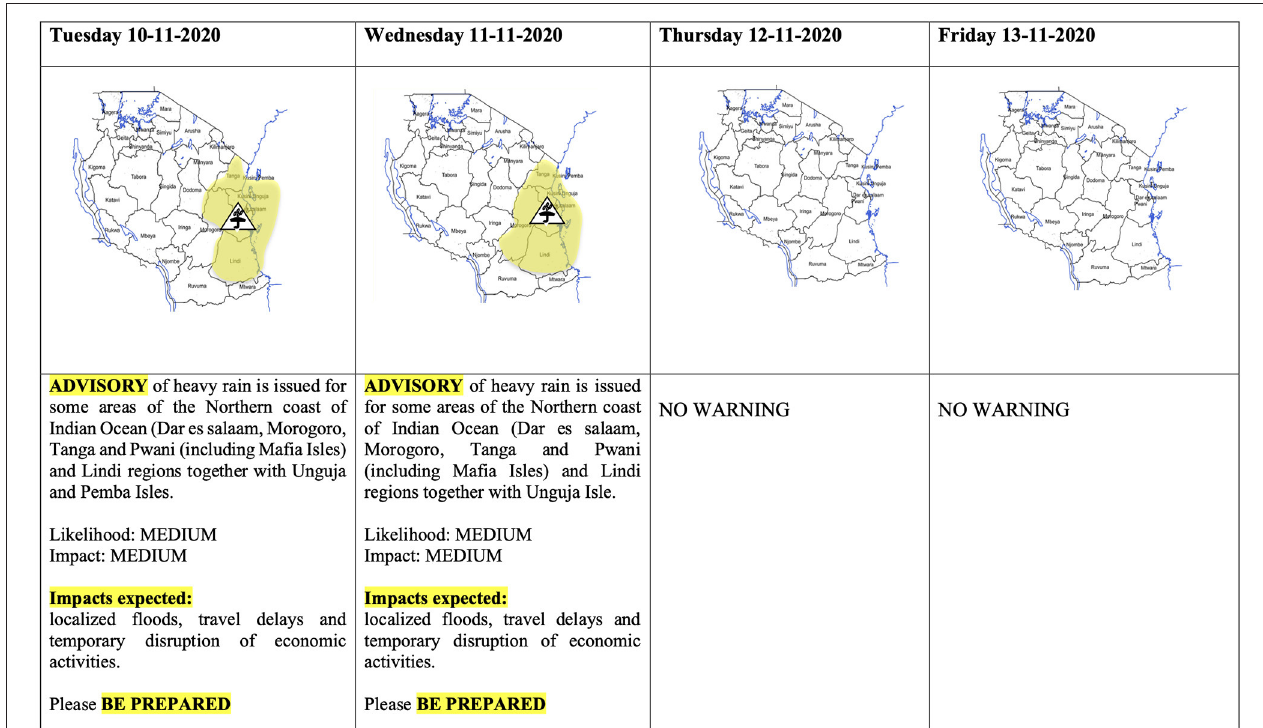
FIGURE 7 | An example of day 2–5 of the TMA severe weather impact-based forecast, indicating warning of heavy rain on day 2, advisories on day 3 and 4 and no warning on day 5 (Forecasting Division, TMA). cyclones, extreme temperatures, and high waves ( Figures 6 , 7